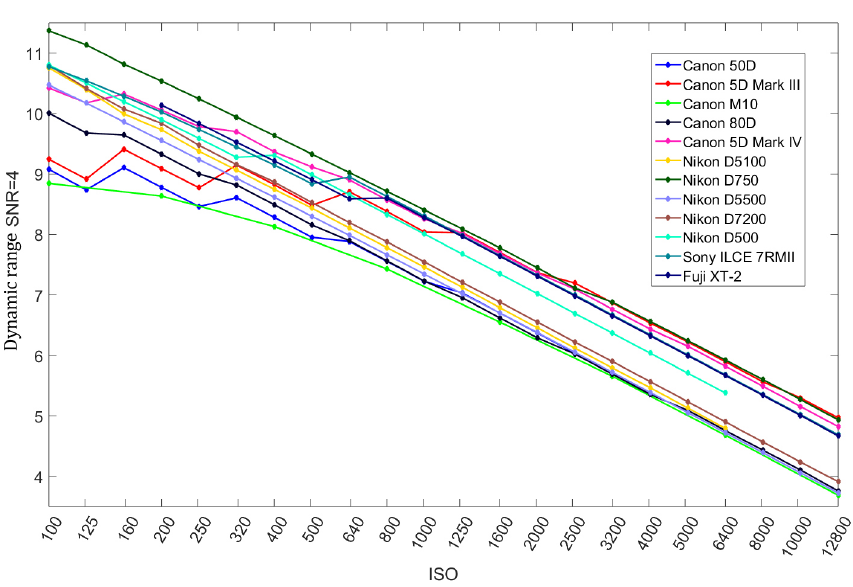
Figure 14. Pixel Dynamic Range for SNR = 2